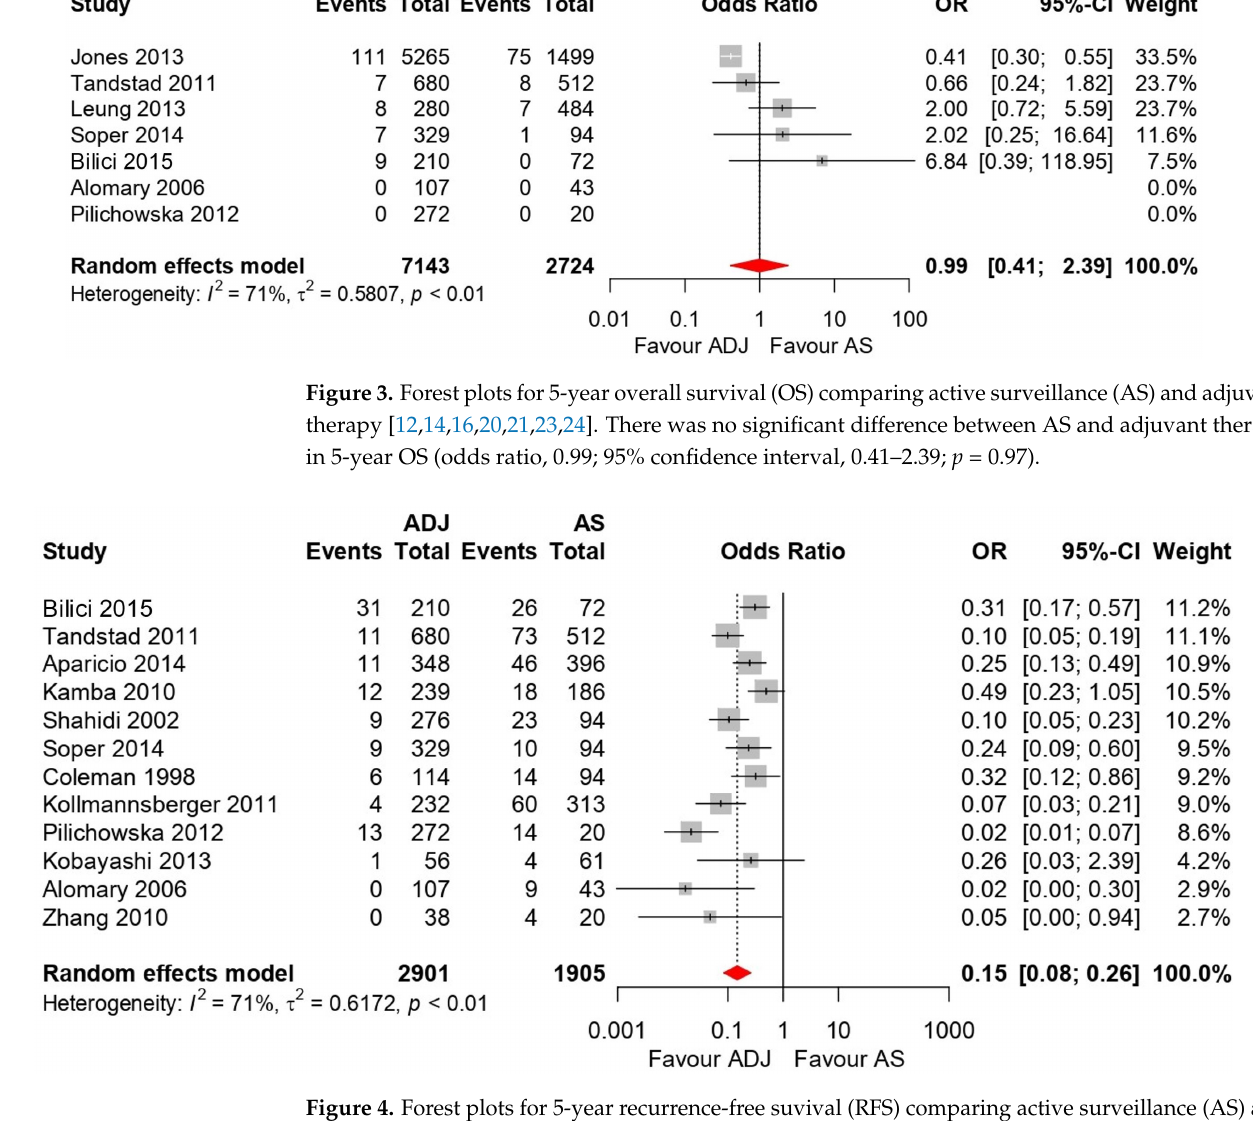
Figure 5. L’Abbe plots of 5 ‐ year overall survival (OS) ( A ) and 5 ‐ year recurrence ‐ free survival (RFS) ( B ). A little heterogeneity was noted in the L’Abbe plots.